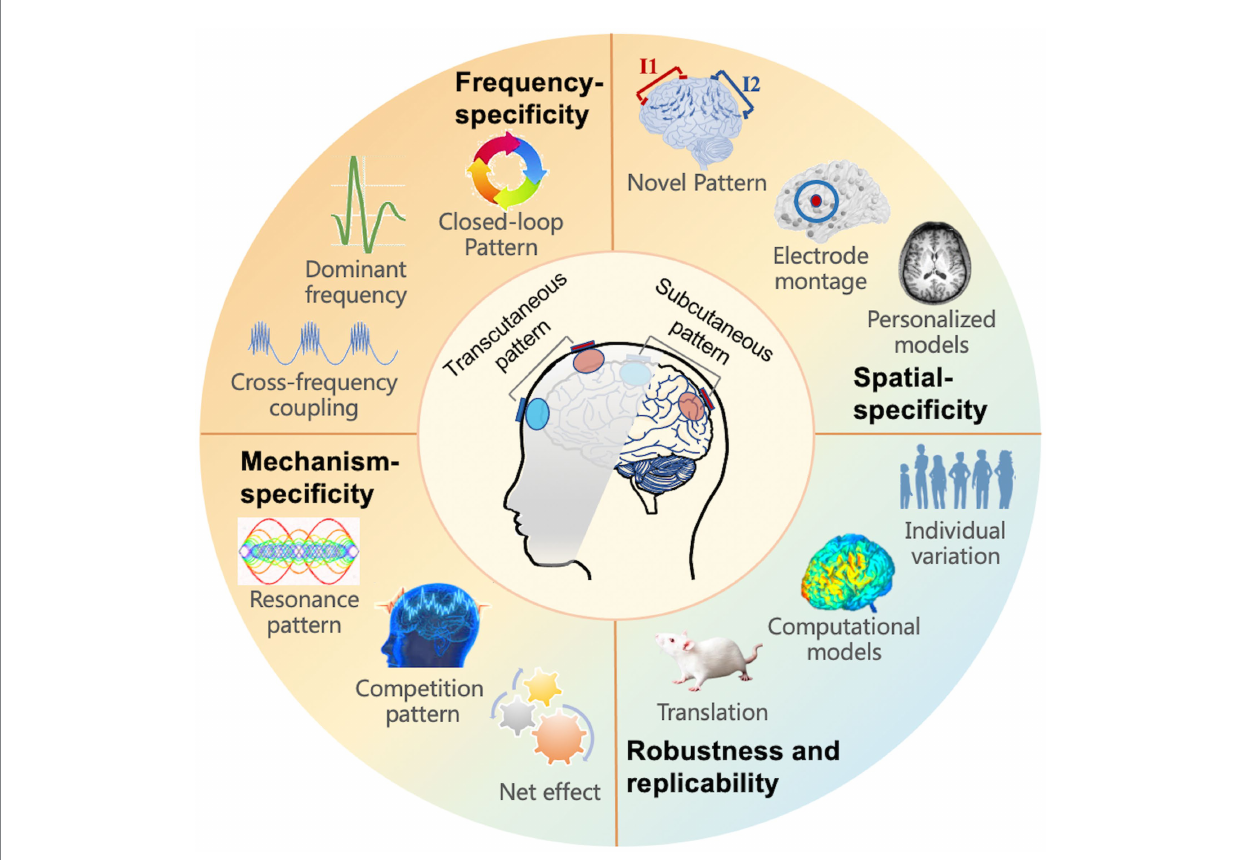
FIGURE 3 Future directions for tACS, including four aspects to take into account: frequency, spatial, mechanism-specificity, as well as robustness and replicability. The subfigure introduces the implicated or prospective study